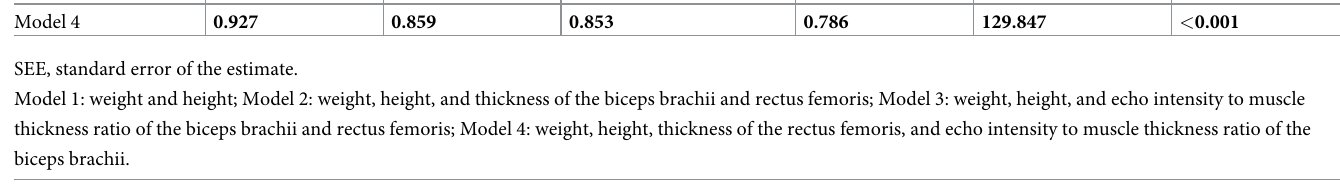
Table 4. Regression models for predicting appendicular skeletal muscle mass in the women group. r